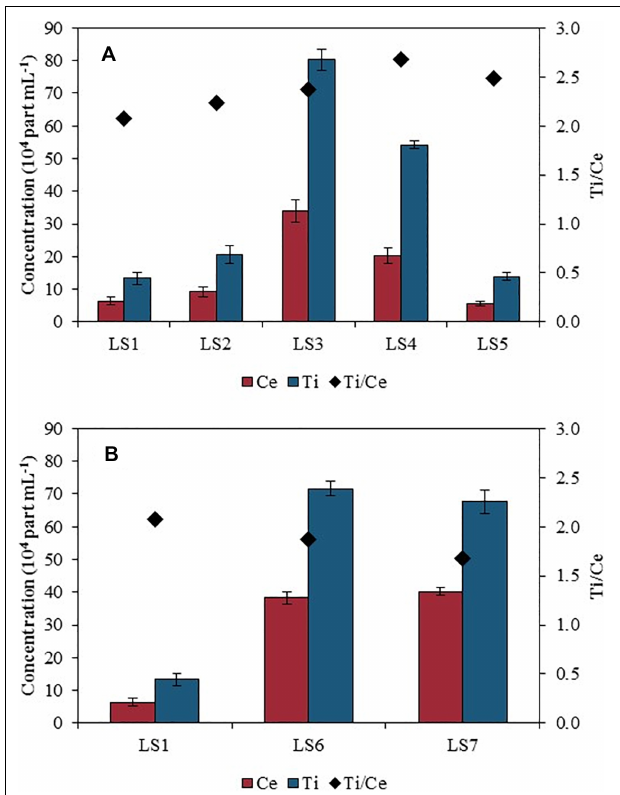
FIGURE 2 | Ce and Ti particle number concentration (PNC, left-hand side axis) and Ti/Ce PNC ratio (right-hand side axis) in the river water measured by spICPMS along (A) Orleans city (LS1 to LS5) and (B) in the outdoor activities center (LS6 and LS7 compared with LS1).